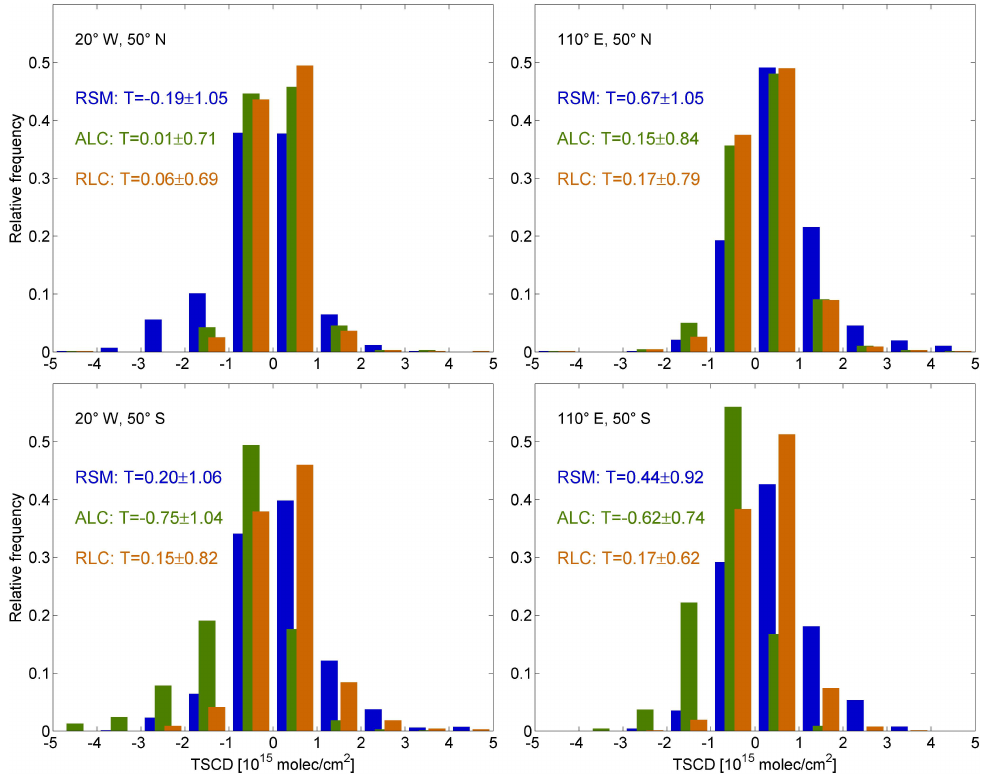
Fig. 12. Frequency distribution of TSCDs for four selected locations (as marked in Figs. 6–10). Upper row: 50 ◦ N. Lower row: 50 ◦ S. Left column: 20 ◦ W. Right column: 110 ◦ E. The different schemes are marked by colors: blue ( T RSM ), green ( T ALC ), and orange ( T RLC ). The numbers give the respective means and standard deviations (in 10 15 molec/cm 2